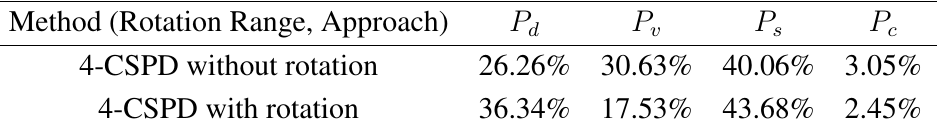
Table 1. Relative contribution to total power of Tokyo Bay area before and after